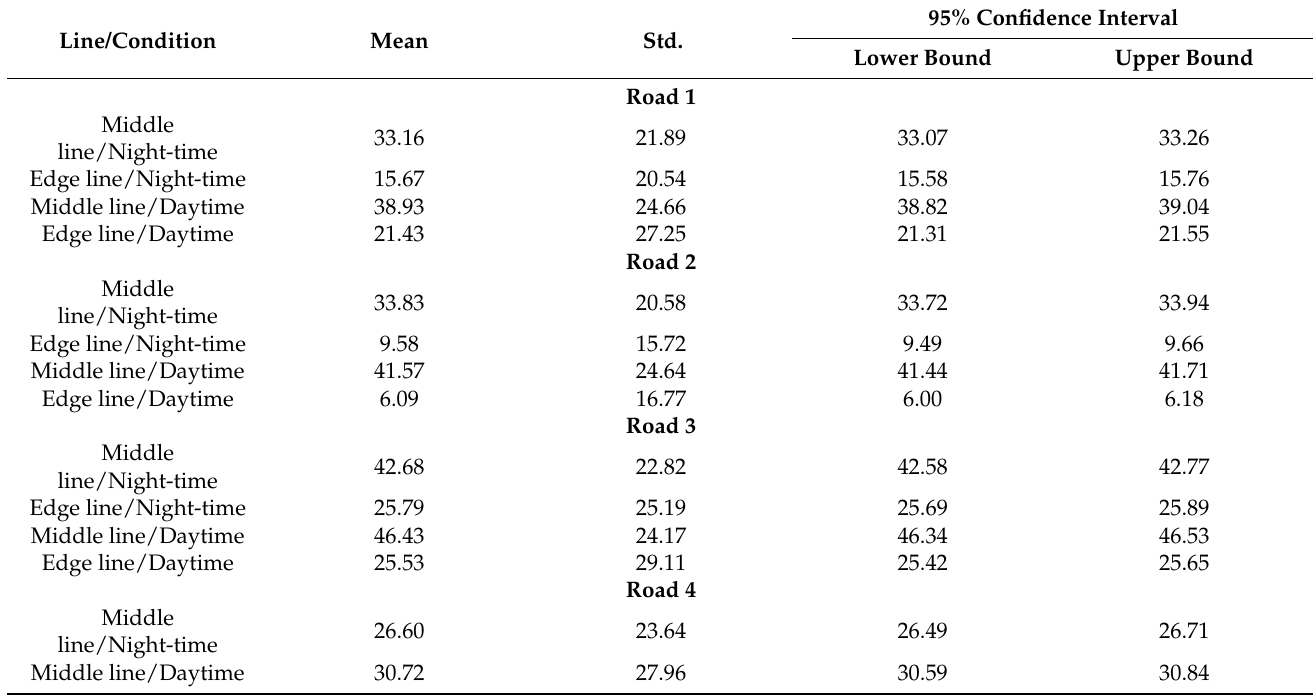
Table 5. Absolute averages of the view range for each road, line and visibility condition.